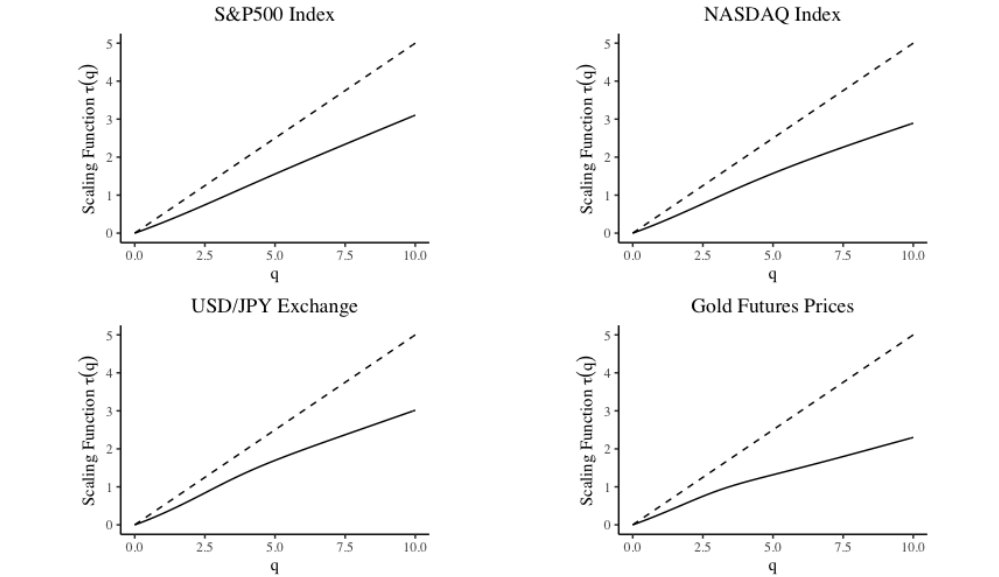
Figure 11. Scaling functions for S&P500, NASDAQ Index, USD/JPY Exchange and Gold Futures Prices during the dot-com bubble (3 January 1994–8 October 2004). The time period from 3 January 1994 to 8 October 2004 corresponds to the dot-com bubble and the dot-com crash.